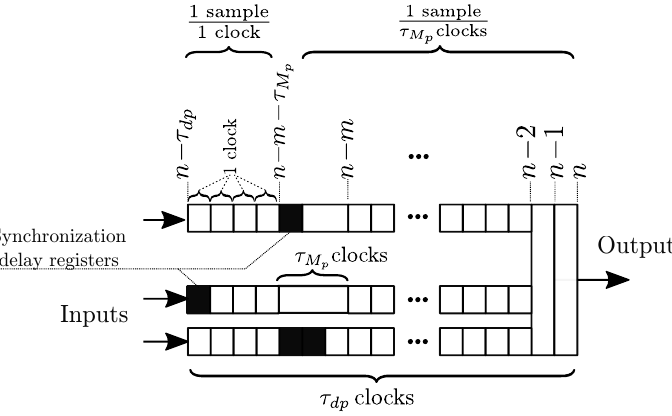
Figure 2. Pipeline block latencies and